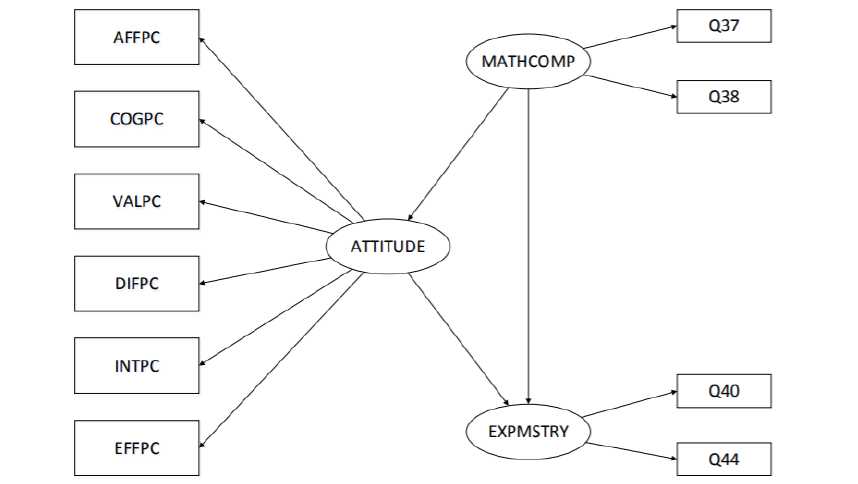
Fig. 1 Theoretical model of attitude, sports ability, and expected